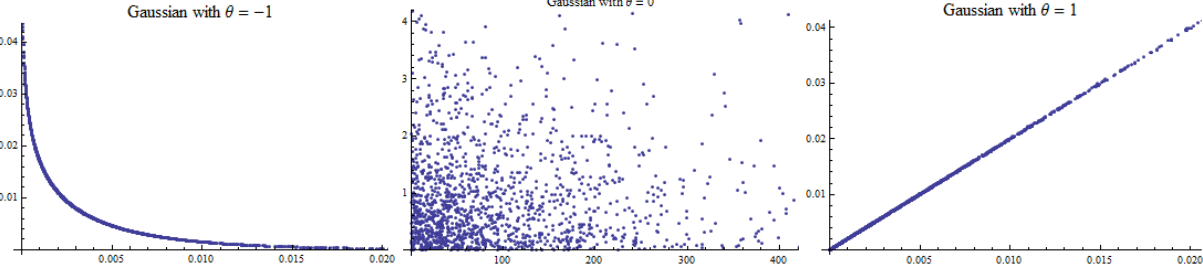
Figure 3. Gumbel copula with exponential margins and dependence parameters one, three, 100.